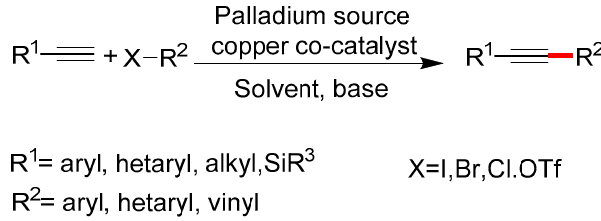
Figure 1. General schematic presentation of Sonogashira Cross Coupling